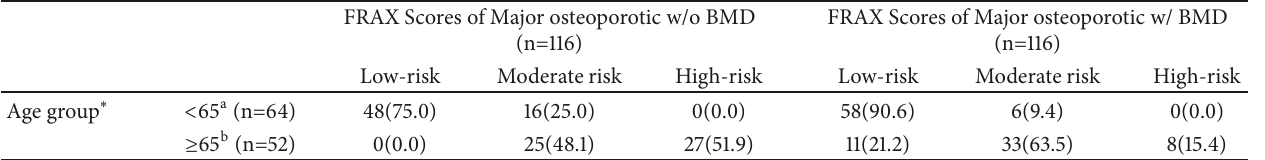
Table 6: The 10-year probability of major osteoporotic fracture stratified by